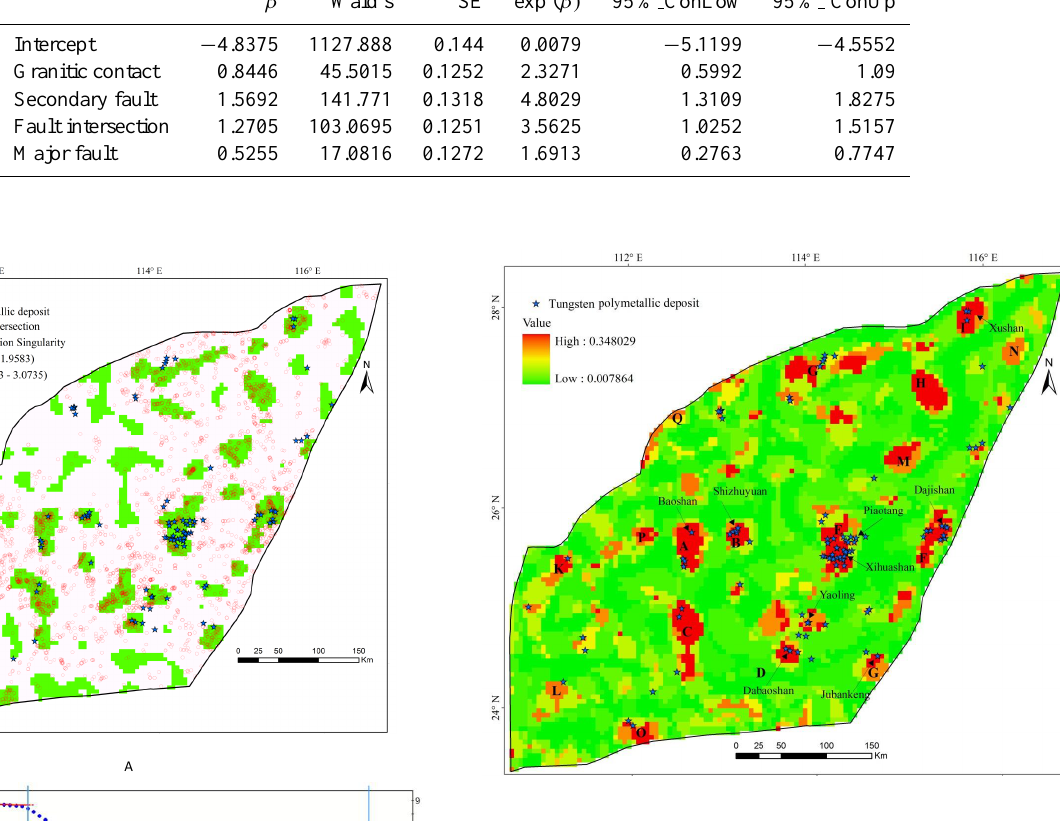
Fig.7. Potential map generated by logistic regression modeling 447 Fig. 7. Potential map generated by logistic regression